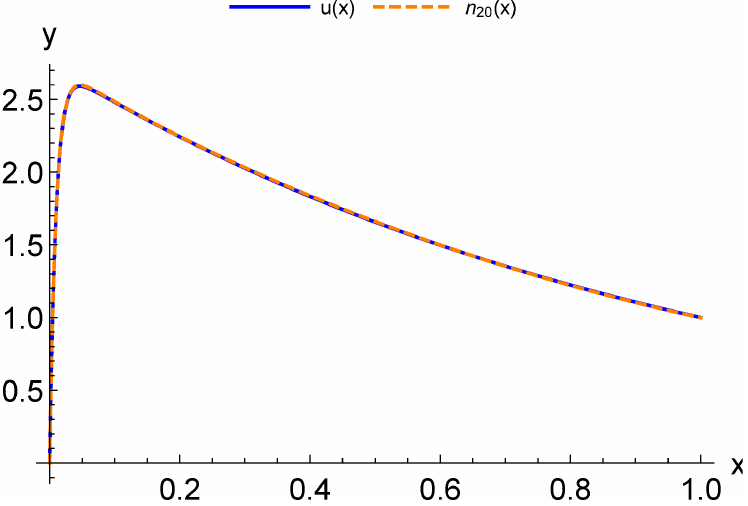
Figure 7. Plots of neural network solution n 20 ( x ) (9) (number of layers n = 20; sigmoid activa- tion functions) as applied to problem (30) and its exact solution u ( x ) (parameter value s = 0.01), corresponding to dashed and solid lines, respectively.